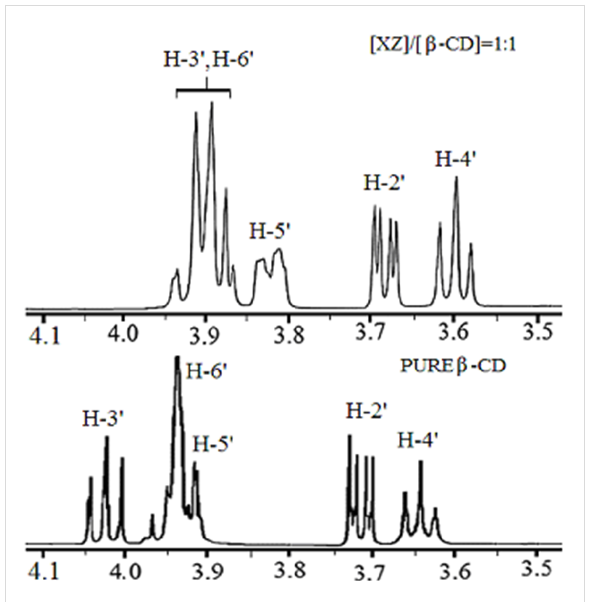
Figure 2: Comparative 1 H NMR spectra of pure β -CD and a 1:1 β -CD–xylazine mixture showing β -CD